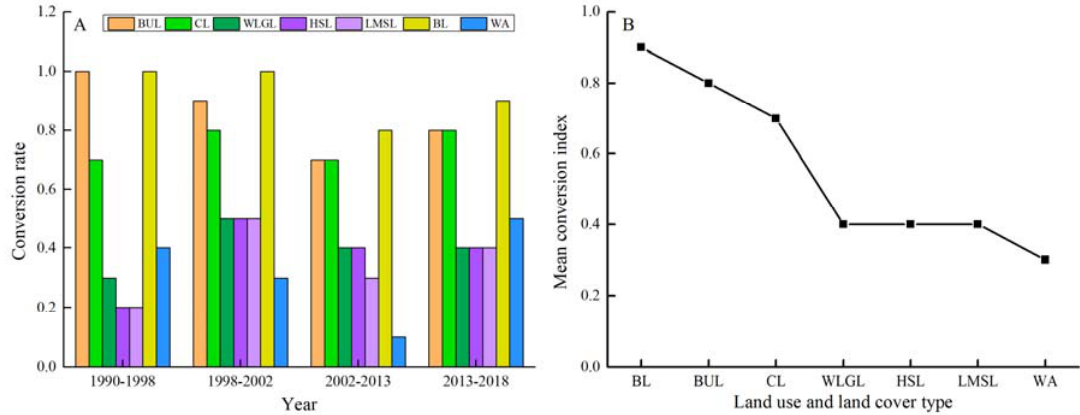
Figure 5. Conversion rate ( A ) and average conversion rate (B ) of the same LULC type in four time intervals (1990 ‐ 1998, 1998 ‐ 2002, 2002 ‐ 2013 and 2013 ‐ 2018) in plain area of Aketao County, China.